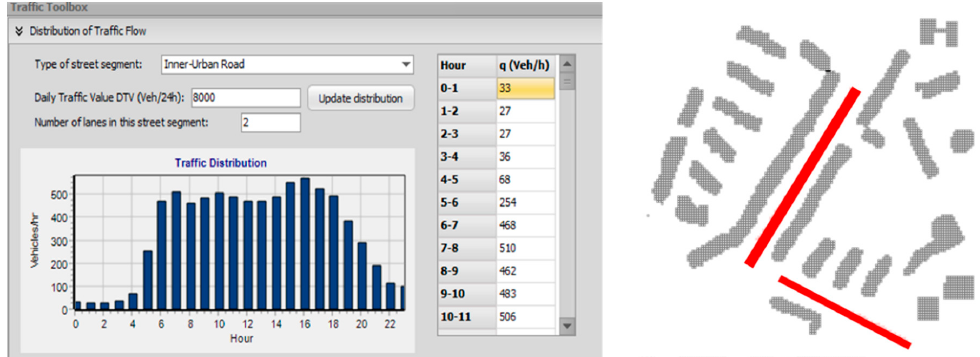
Figure 3. Left: screen of traffic toolbox in ENVI-met with details of default traffic distribution during the day. Right: the linear sources located in the street canyons (red rectangles).